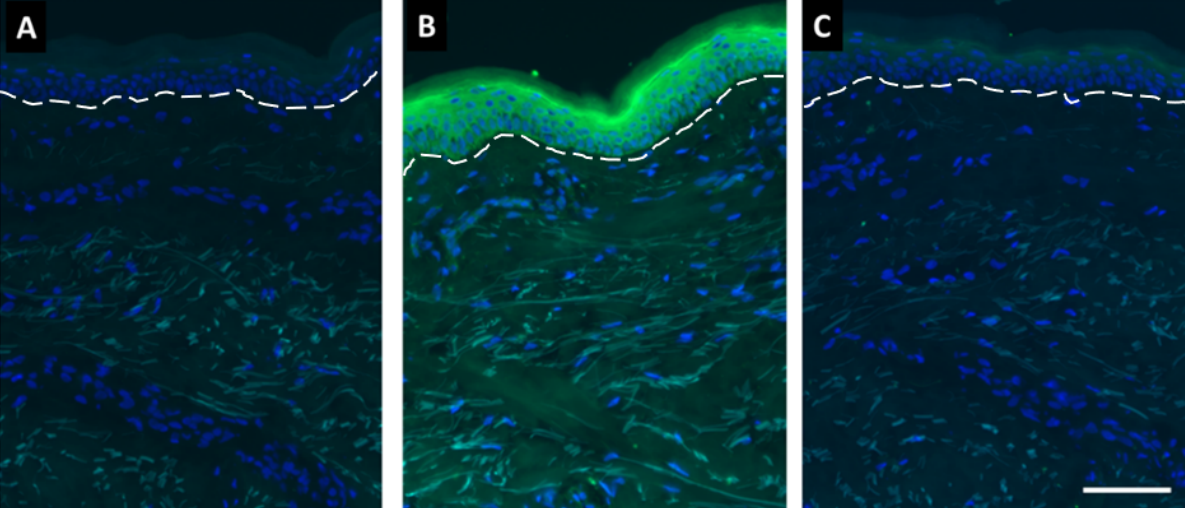
Figure 9. Fluorescent images of frozen human skin sections. Green color in epidermis is bilirubin; blue color indicates DAPI staining. Green signals observed in dermis in nontreated control are due to autofluorescent property of elastin. White dotted line indicates dermal–epidermal junction: ( A ) nontreated control; ( B ) 50 µg/mL bilirubin; ( C ) 50 µg/mL bilirubin + 0.01% SDL. Scale bar = 100 µm.